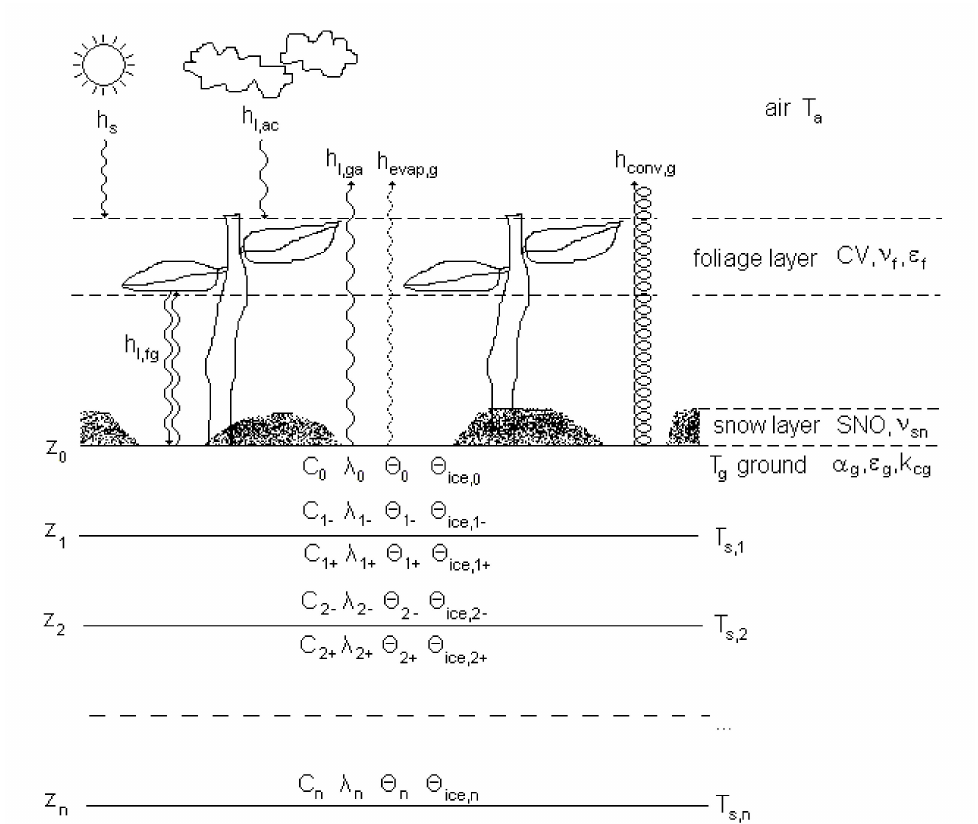
Figure 2. Heat flow and heat exchange roadmap of AGRISOTES